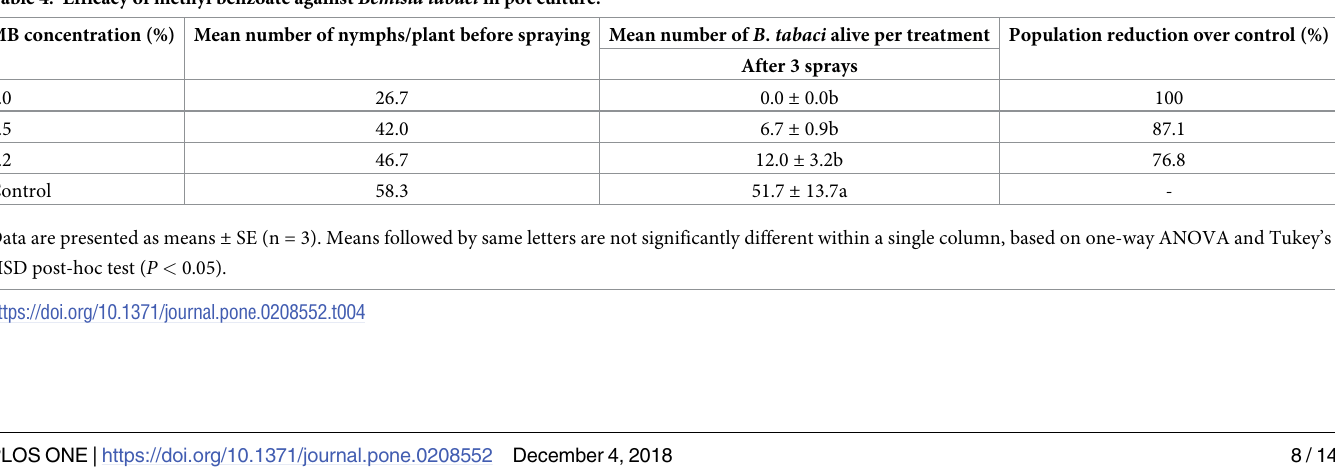
Table 4. Efficacy of methyl benzoate against Bemisia tabaci in pot culture.